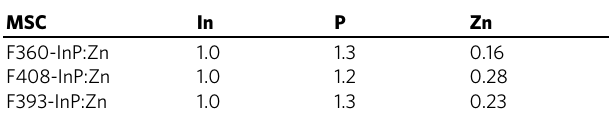
Table 2 Chemical compositions (atomic %) of F360-InP:Zn MSCs, F408-InP:Zn MSCs, and F393-InP:Zn MSCs, obtained using